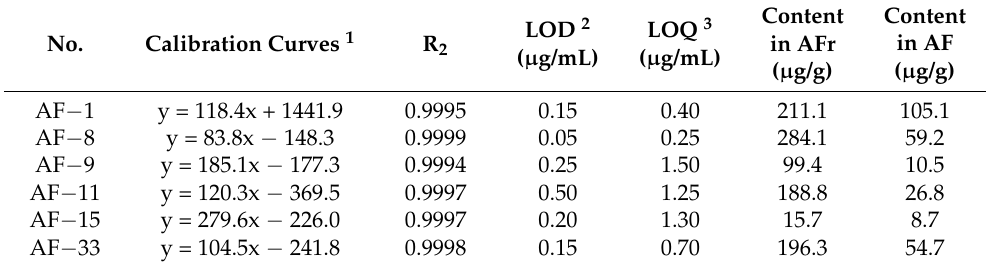
Table 1. Quantitative analysis of twelve flavonoids in the AF and the